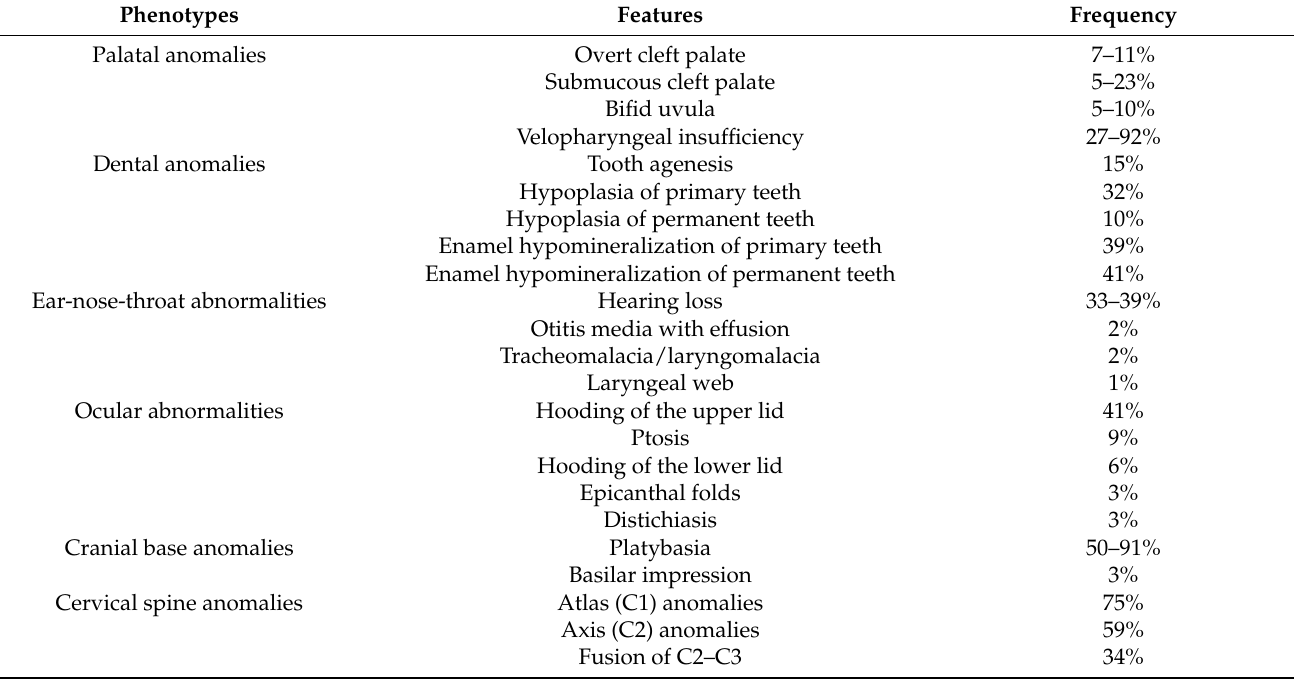
Table 1. Craniofacial anomalies in patients with DGS/VCFS.